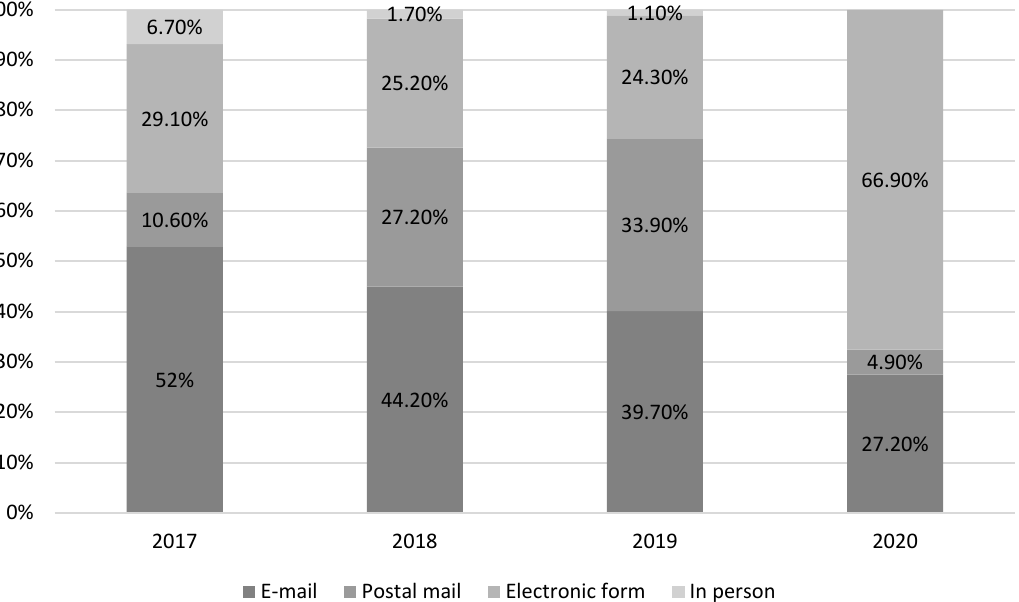
Figure 3. Reported discriminatory practices presented to CICDR by services ( n )—2017 to 2020. Source: Data retrieved from CICDR (2017, 2018, 2019, 2020). In terms of regions, we highlight in this figure those which report the highest number of complaints and that, according to data from SEF (SEF/GEPF 2021), are among the